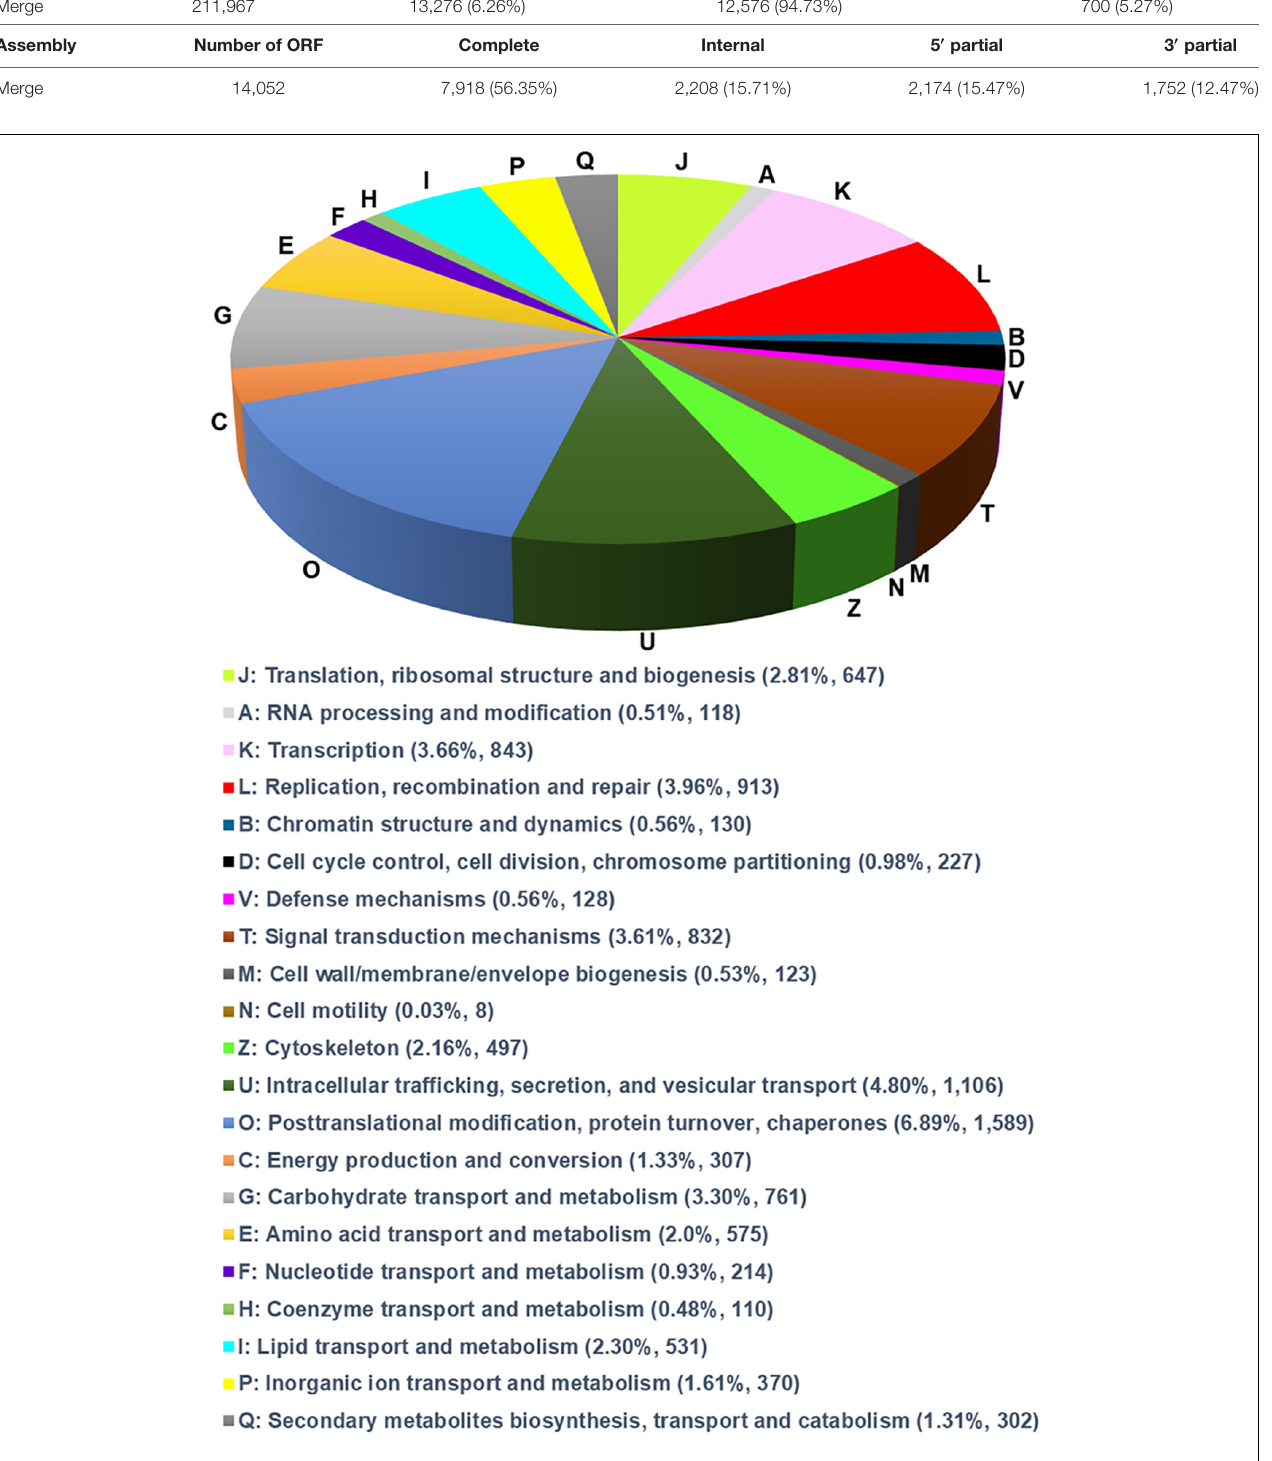
FIGURE 1 | Annotations of the annotated unigenes. The annotated unigenes are mapped to the annotation of the corresponding orthologous groups in EggNOG (evolutionary genealogy of genes) database.